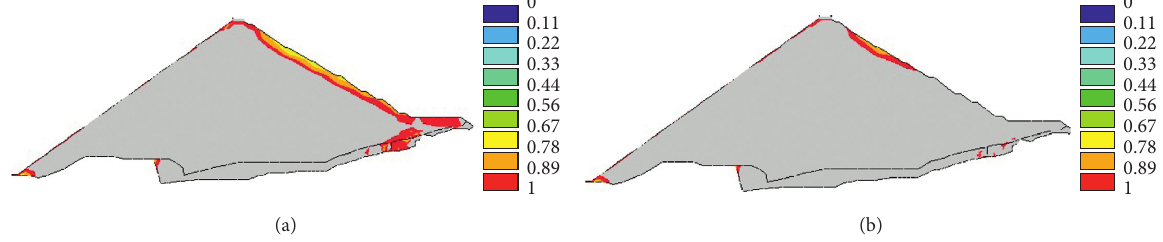
Figure 15: Distribution of safety factor below 1.0 (0.50 g of soil elements (SRRS). (a) UHS. (b) SRRS.